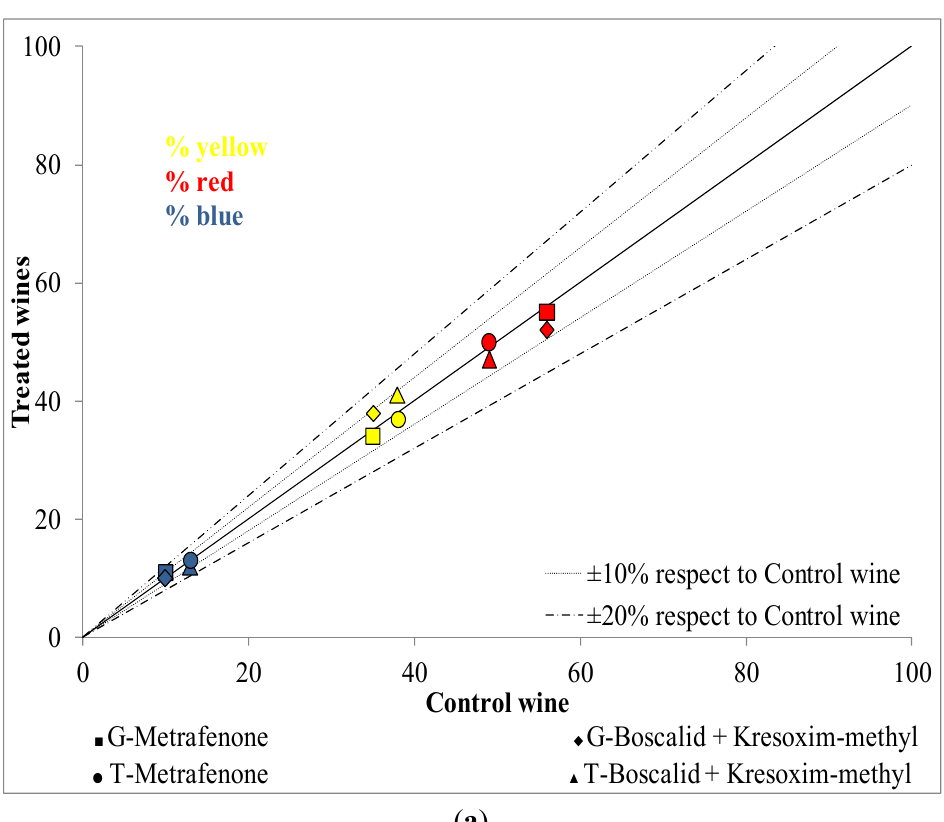
Figure 1. Colorimetric indexes ( a ) and CIELab data ( b ) of treated wines (Y axis) and control wines (X axis) for Graciano (G) and Tempranillo (T)